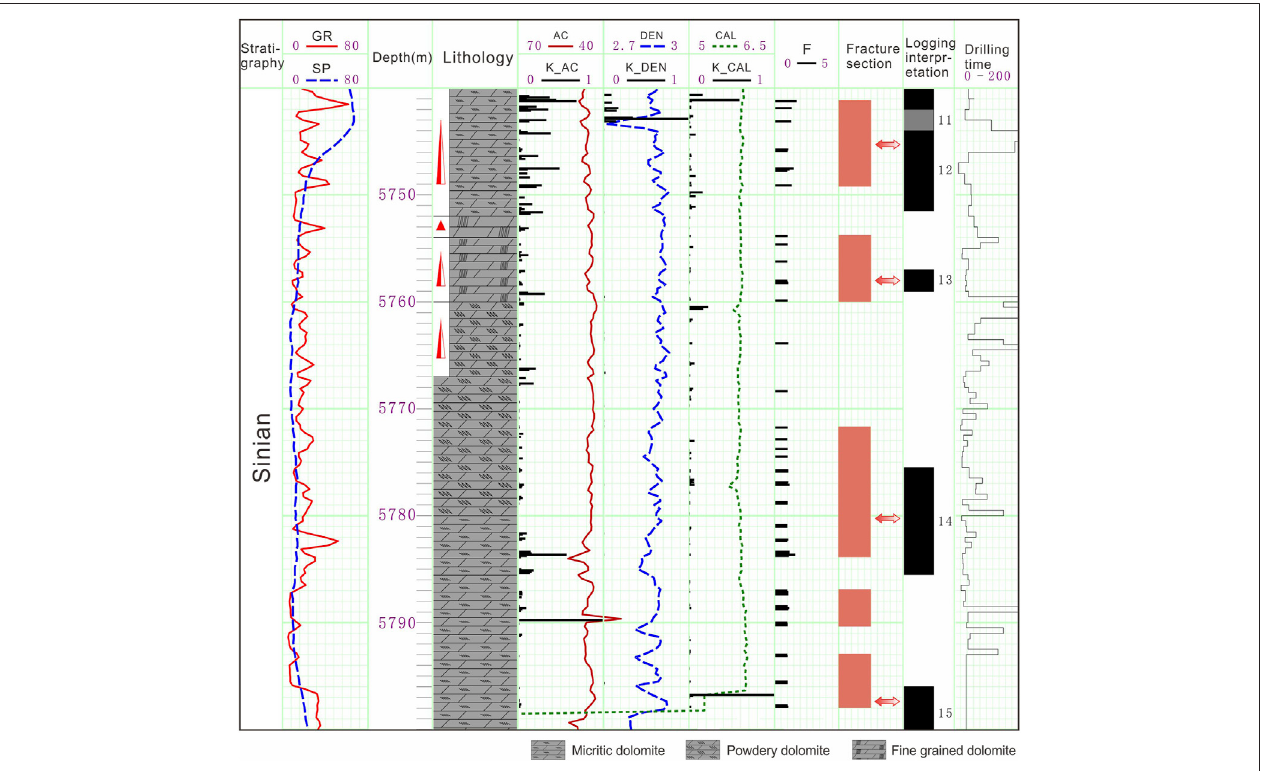
FIGURE 7 | Results of fracture development section identi fi ed with the R/S-FD method in well Q1. The red and white double arrows show the corresponding relationship between the fracture development section and the conventional logging interpretation section.